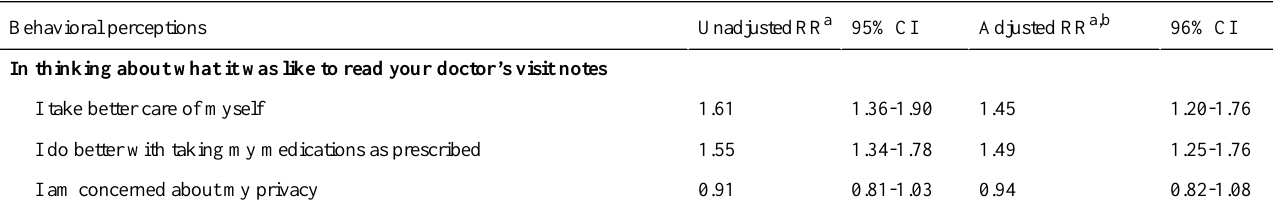
Table 5. Behavioral perceptions in patients who shared visit